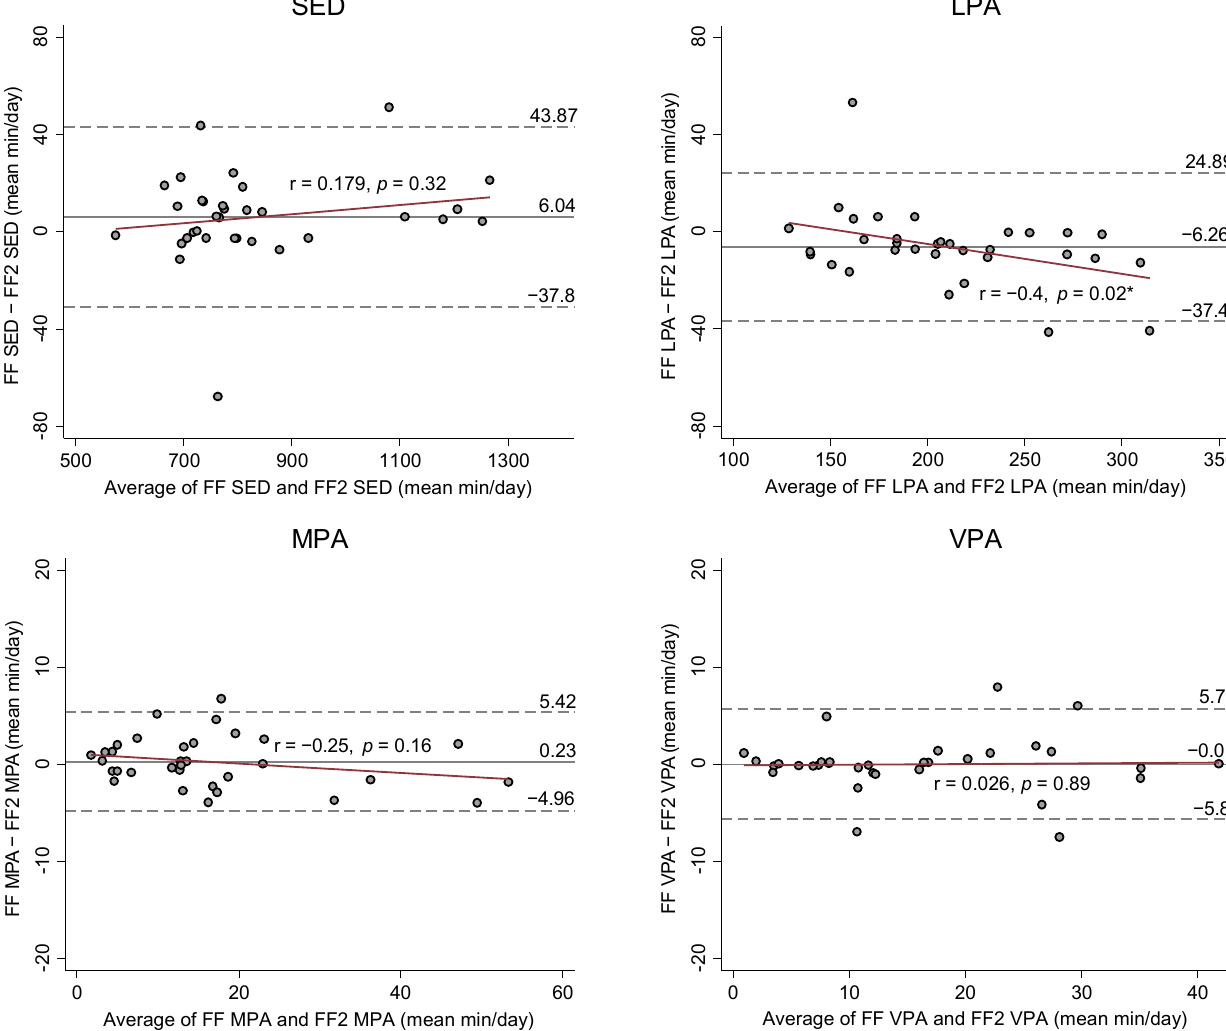
Figure 2 . Bland-Altman plot comparing estimates of SED and PA between FF and FF2. Dashed lines show 95% limits of agreement (±1.96 standard deviation); SED: Sedentary behavior; LPA: Light physical activity; MPA: Moderate physical